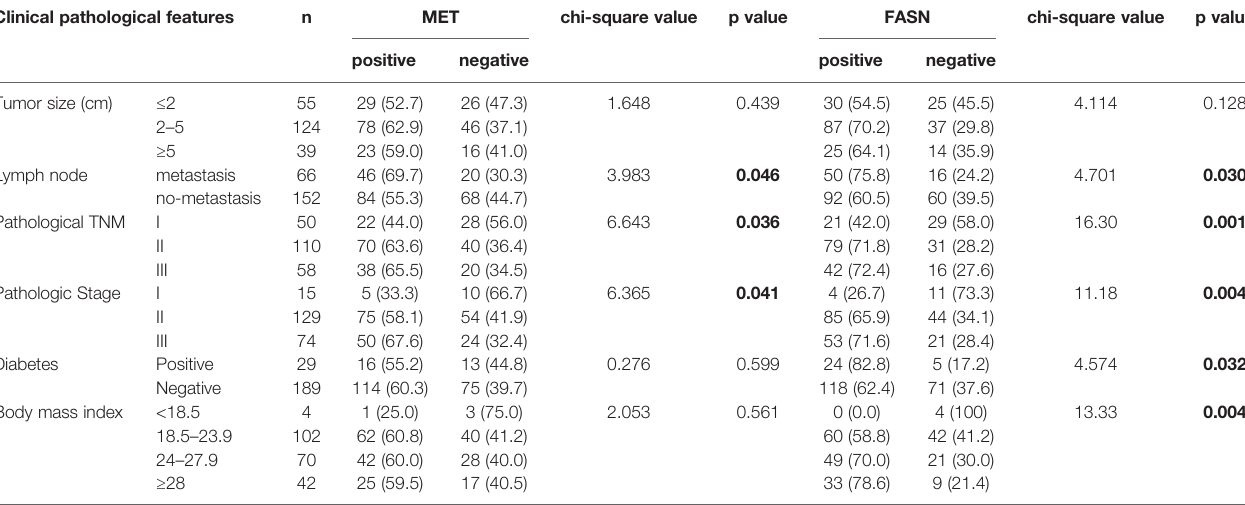
TABLE 3 | The relationship of MET and FASN with the clinical pathological features in TNBC. Clinical pathological features